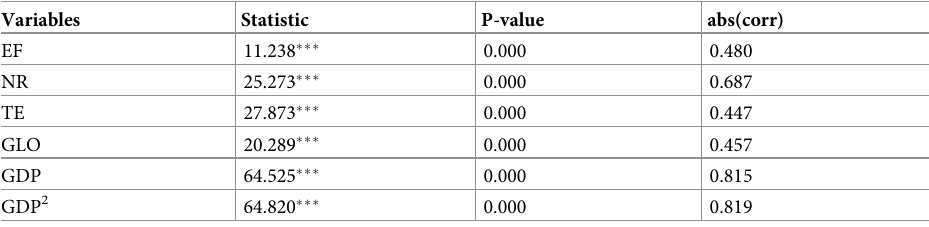
Table 1. Cross-sectional dependence test